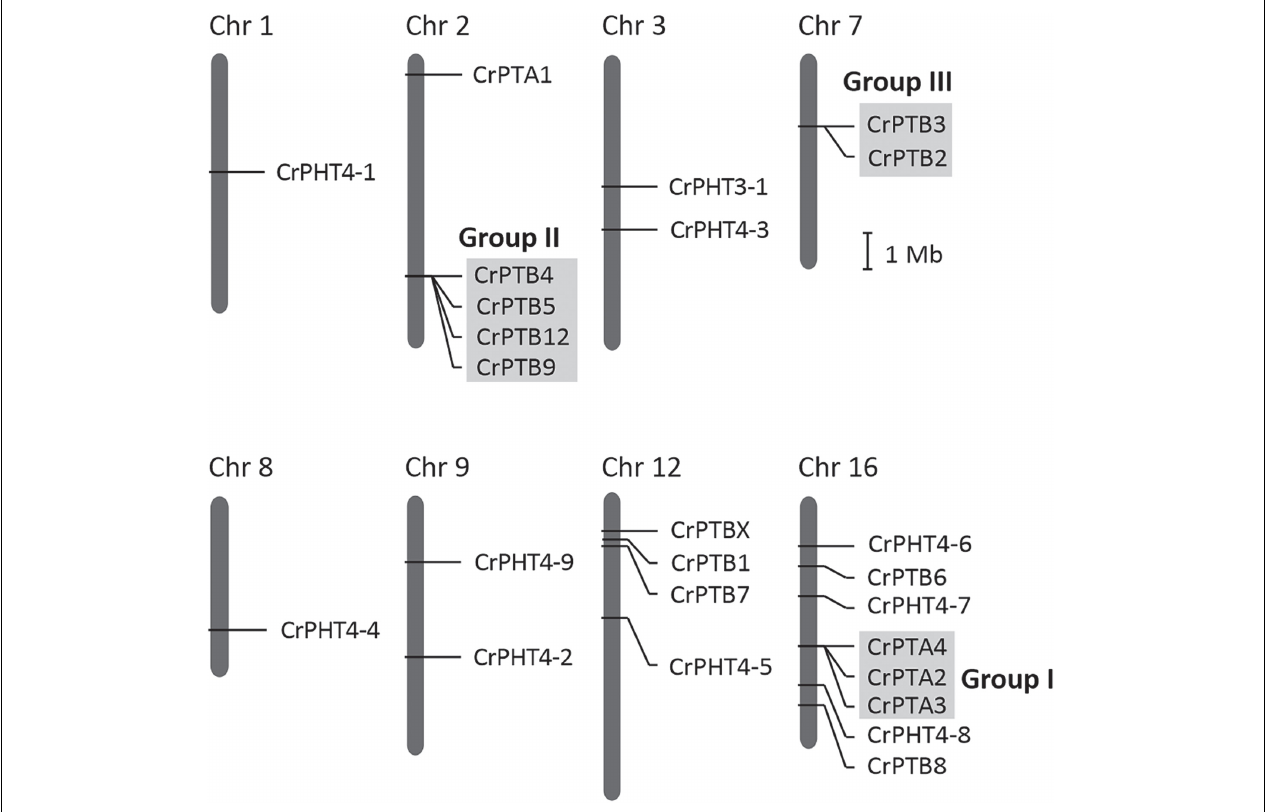
FIGURE 2 | Chromosomal location and gene duplication of PHT proteins in Chlamydomonas. Chromosome numbers are shown at the top of each bar. Recent tandem duplicated genes were marked with a gray background. The scale presented on the left indicates chromosome sizes in megabases